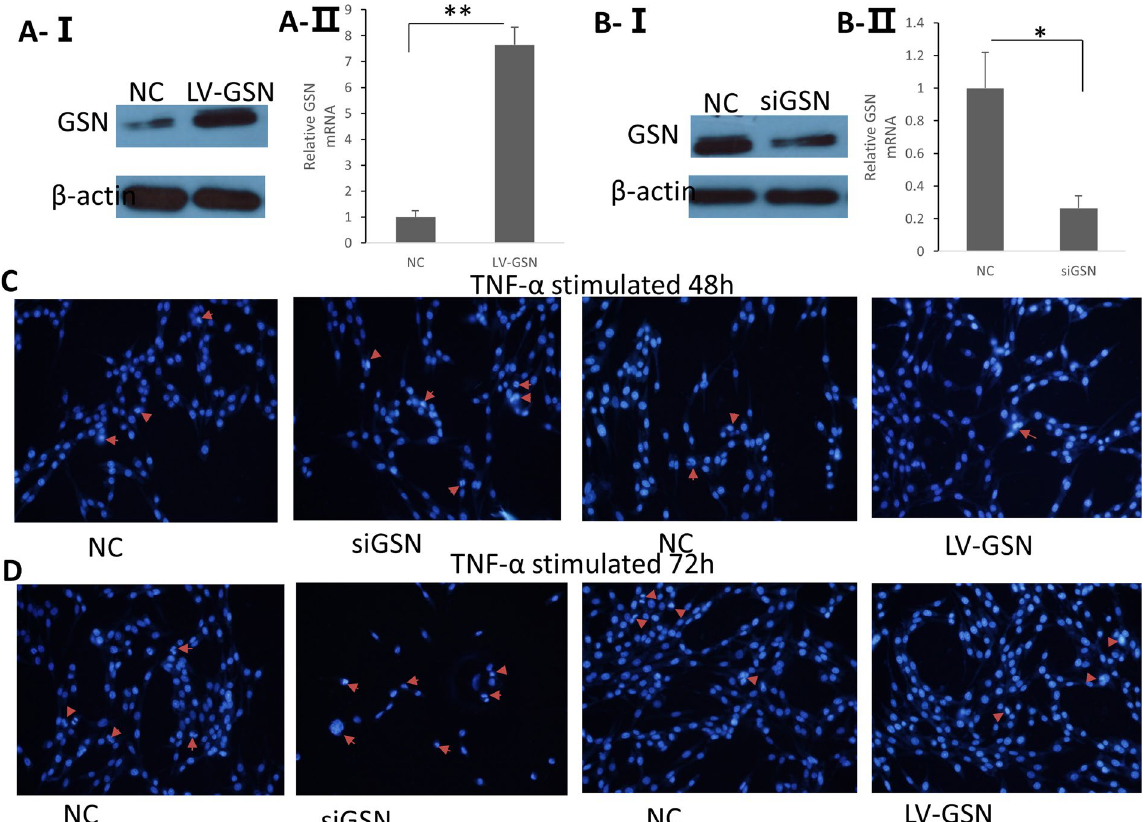
Figure 6. GSN expression has a deep relationship with decreased apoptosis. ( A ) GSN overexpression was verified by Western blot analysis and real-time PCR following transfection with LV-GSN or control (NC) lentivirus for 72 h. ( B ) GSN interference in PC12 cells was confirmed by Western blot analysis and real-time PCR following transfection with siGSN or control (NC) siRNA oligonucleotides for 72 h. The blots shown in Fig. 6A and B are cropped; the uncropped full-length gels are presented in the Supplementary Figure (Fig. S1B). ( C,D ) Levels of apoptosis were assayed by Hoechst 33258 staining 48 or 72 h following transfection and exposure to TNF- α . Images of the stained cells were captured under a fluorescent microscope at 350 nm stimulation and 460 nm emission ( × 100